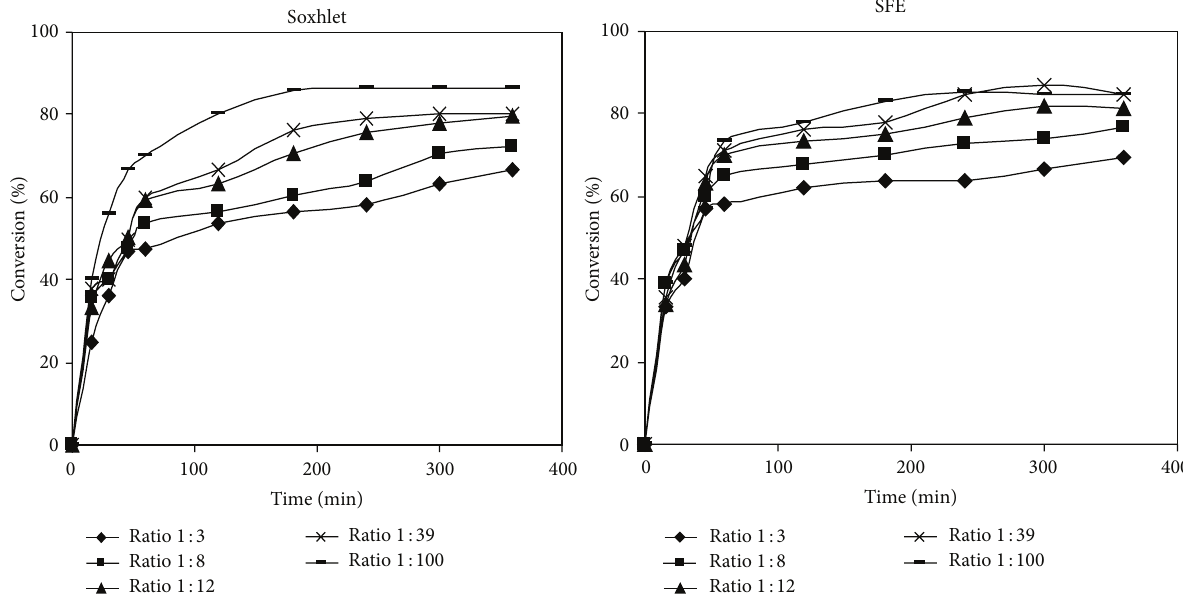
Figure 6: Base-catalysed transesterification of oils obtained by Soxhlet extraction and by SFE with carbon dioxide at 400 bar and 35 ∘ C.